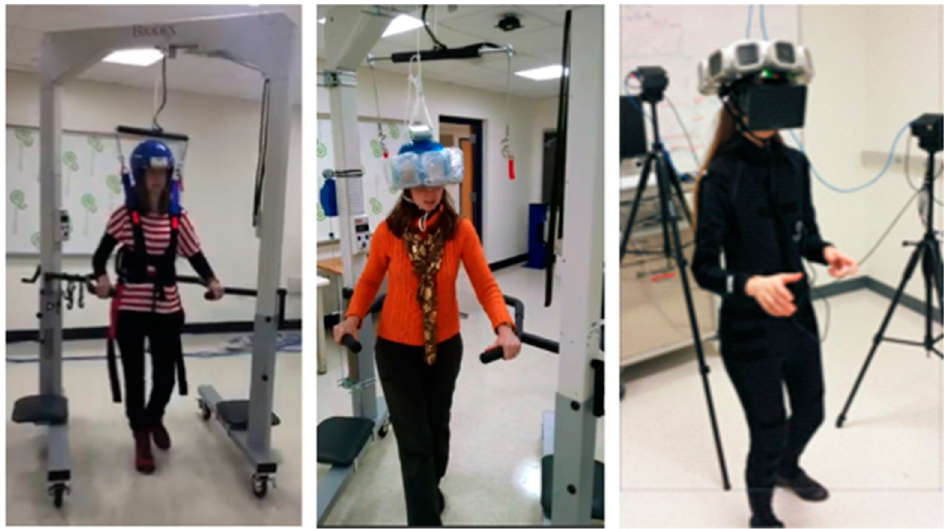
Figure 10. The Generation 1 fully mobile upright safe design using counterbalanced weight support of the adapted Biodex system allows for the subject can push the wheeled support to move along. In the center is shown the (passed) realistic test with a 10 kg mockup helmet (with lead weights used instead of detector modules simulation similar volume and weight compared to the functional sensor modules incl. casing and cables). The subject could also sit or stand, or even walk with VR goggles.